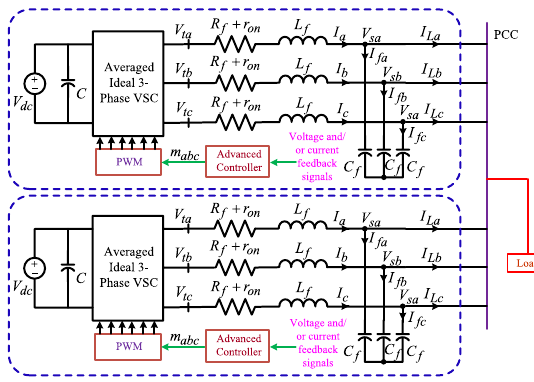
Fig. 1 Schematic diagram of 3-phase VSIs connected in parallel and operated in the islanded MG